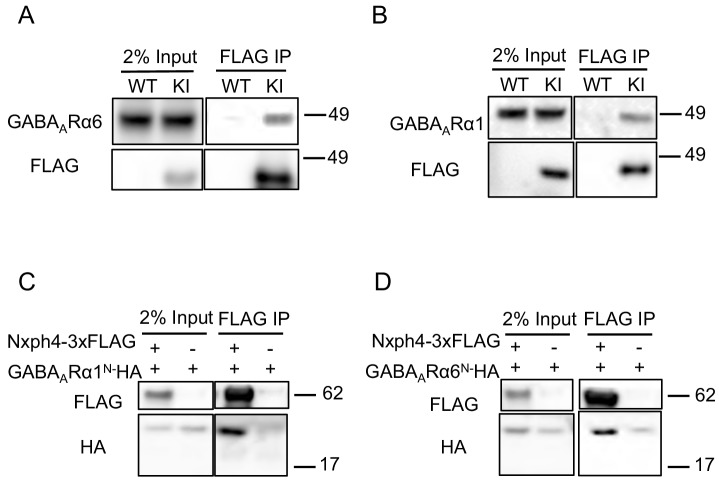
Nxph4 interacts with GABAARs.(A,B) Cerebellar synaptosomes from three Nxph4-3xFLAG KI or WT (negative control) mice were precipitated with an antibody against FLAG. Bound proteins as well as 2% input were analyzed by immunoblotting with anti-FLAG and anti-GABAARα6 (A), or anti-GABAARα1 (B) antibodies as indicated. (C) Nxph4-3xFLAG and the N-terminal extracellular domain of GABAARα1 were co-expressed in HEK293T cells. Cell lysates were precipitated with an anti-FLAG antibody and elution was analyzed by immunoblot showing the precipitation of Nxph4-GABAARα1N complex. Cells transfected with GABAARα1N-HA alone were used as negative control. (D) Nxph4-3xFLAG binds to the N-terminal extracellular domain of GABAARα6.